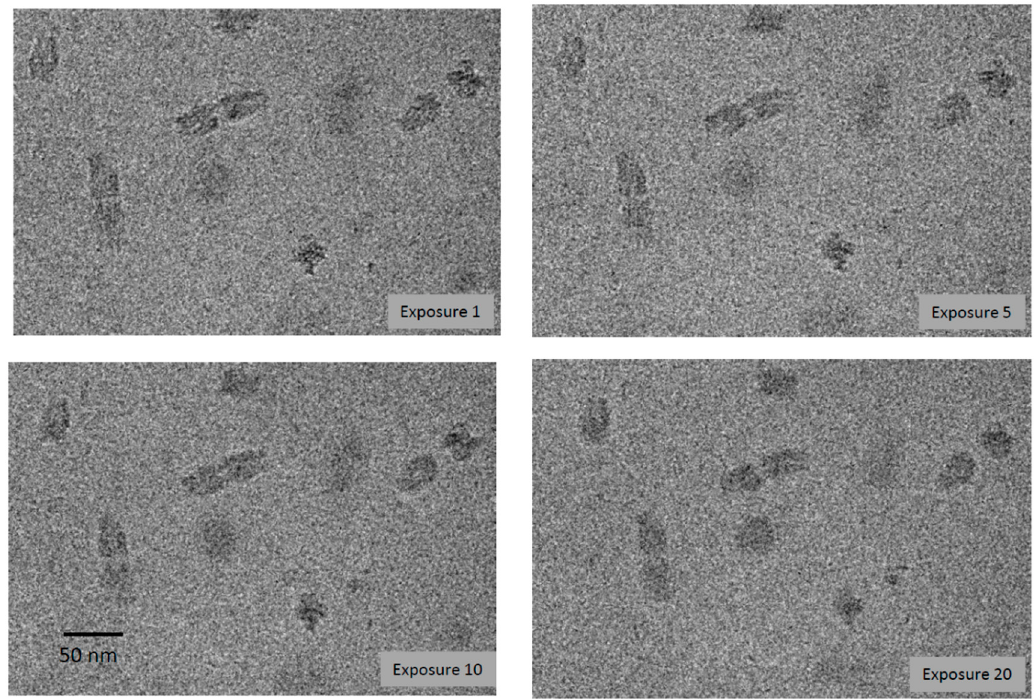
Figure 1. Cryo-electron micrographs from a dose series of images of DNA origami.